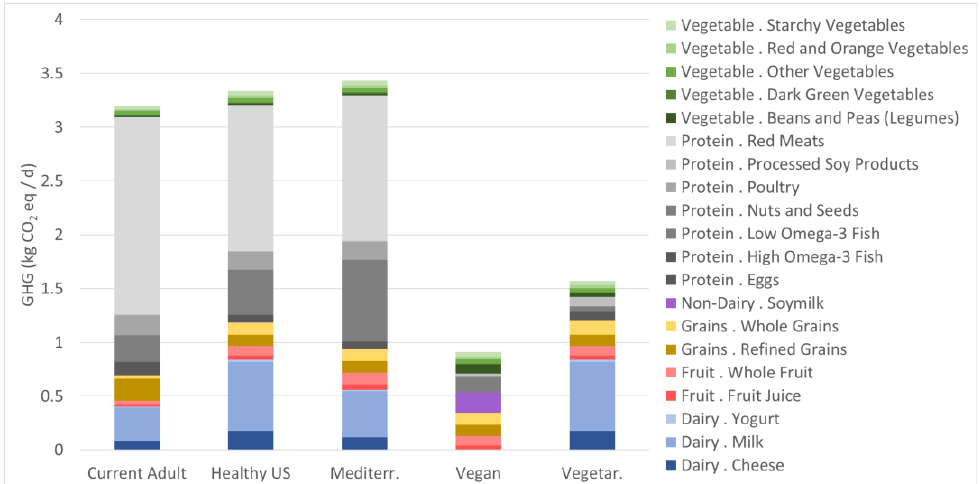
Figure 3. GHG life cycle emissions for five diets reflecting an average of 2000 kcalories (recommended diets) or 2155 calories (Current diet), with major food group (dairy, fruit, grains, non-dairy, protein, and vegetable) and subgroups indicated by column colors.